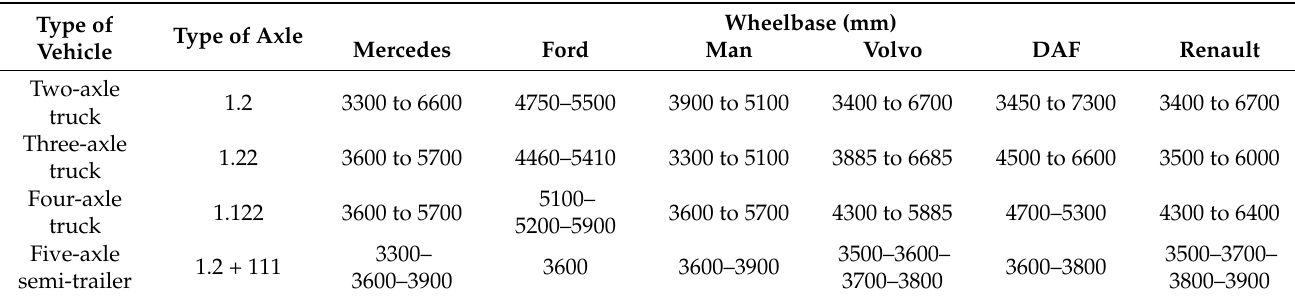
Table 3. Wheelbases used in various commercial